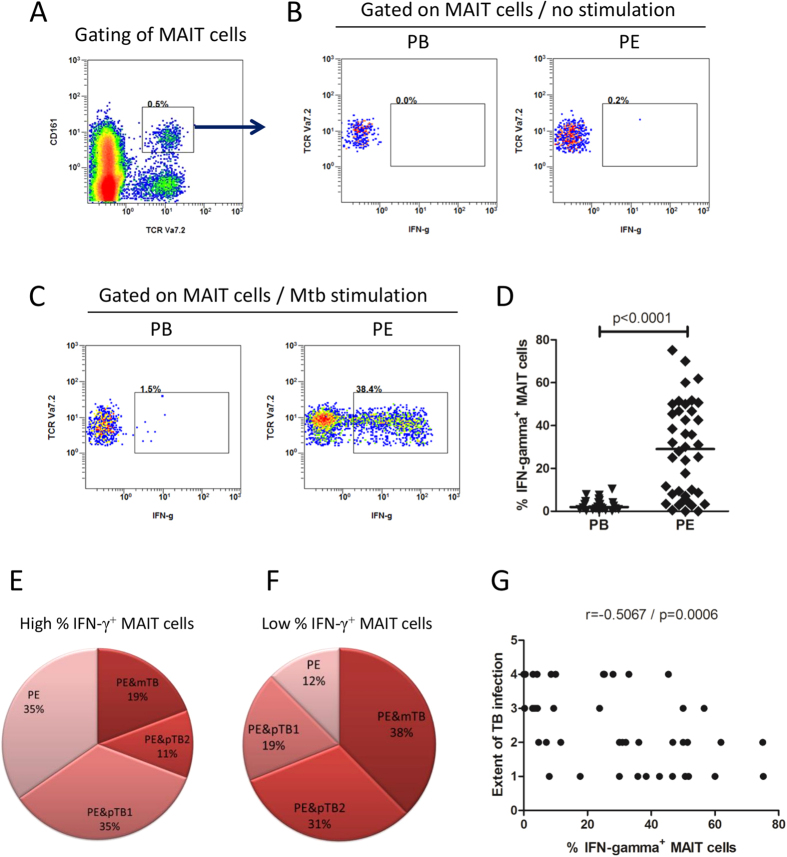
IFN-γ production in MAIT cells from tuberculous pleural effusions and peripheral blood.(A) Representative flow cytometric plot showing gating of MAIT cells with phenotypes of CD3+Vα7.2+CD161high. (B) Representative flow cytometric plots showing IFN-γ production in MAIT cells from peripheral blood (PB) and from tuberculous pleural effusion (PE) of patient with tuberculous pleurisy in the absence of antigen stimulation. (C) Representative flow cytometric plots showing IFN-γ production in MAIT cells from peripheral blood (PB) and from tuberculous pleural effusion (PE) of patient with tuberculous pleurisy after Mtb antigen stimulation. (D) MAIT cells in tuberculous pleural effusions had greatly enhanced IFN-γ response to Mtb antigens compared with those in peripheral blood. Horizontal Bars in the scatter plots indicate median. (E) The ratio of patients with tuberculous pleurisy only (PE), with accompanied pulmonary TB with lesions located within one lung (PE & pTB1), with accompanied pulmonary TB with lesions located in both lungs (PE & pTB2), and with accompanied pulmonary TB and other extrapulmonary TB (PE & mTB) in the high IFN-γ-producing MAIT cell group. (F) The ratio of patients with different extent of TB infections in the low IFN-γ-producing MAIT cell group. (G) Correlation analysis showed that the frequency of IFN-γ-producing MAIT cells was inversely correlated with the extent of TB infection. The extend of TB infection was graded from 1 to 4, representing PE, PE&pTB1, PE&pTB2 and PE&mTB respectively, as described in legend in Fig. 1E. The nonparametric Mann-Whitney test was used for statistical analysis in Fig. 1D.